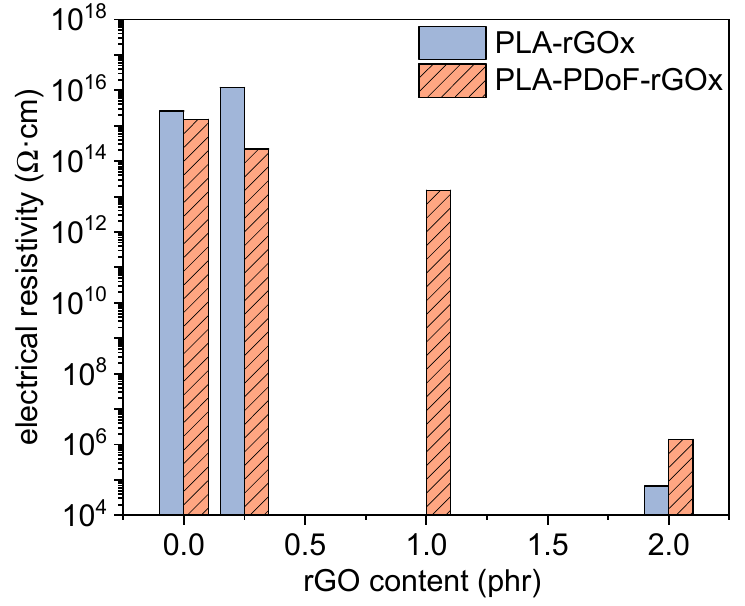
Figure 13. Log-scale volume electrical resistivity of the prepared films. The data dispersion was never higher than 10 Ω ·cm.